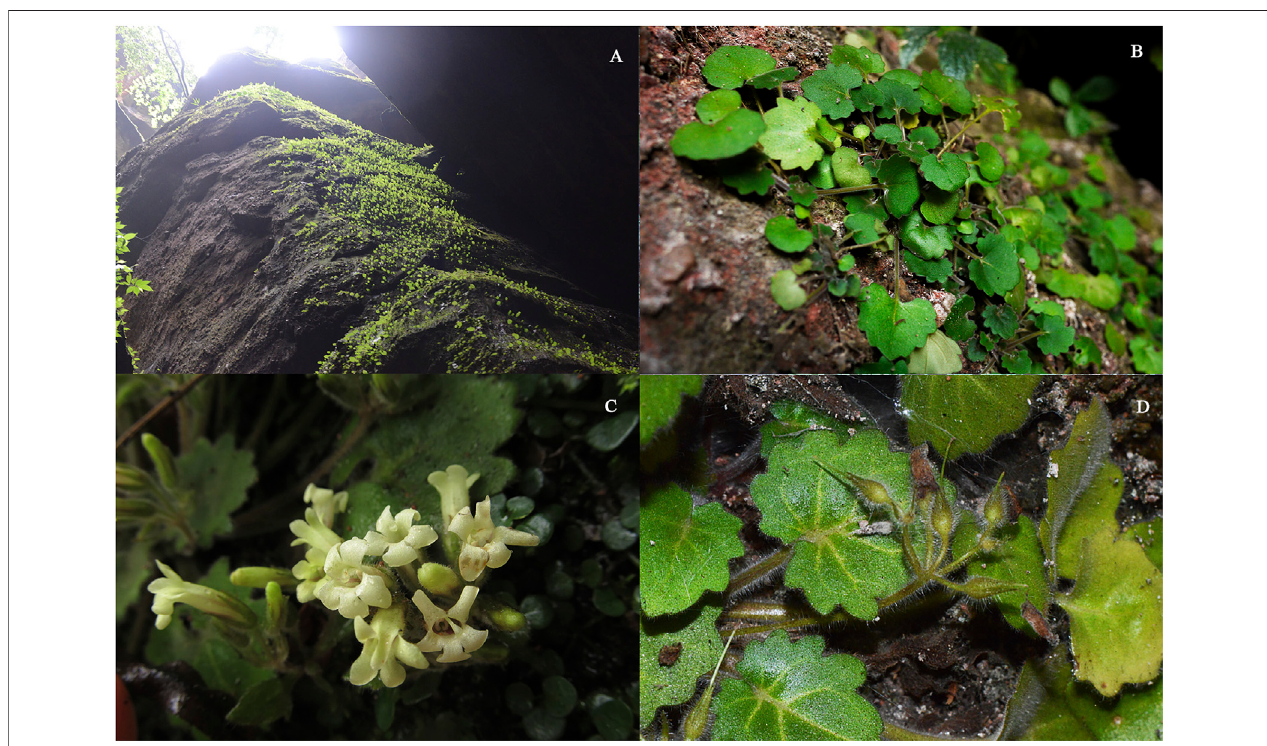
FIGURE 1 | Primulina danxiaensis W. B. Liao, S. S. Lin, and R. J. Shen. (A) Typical habitat. (B) Habit. (C) Flower. (D)